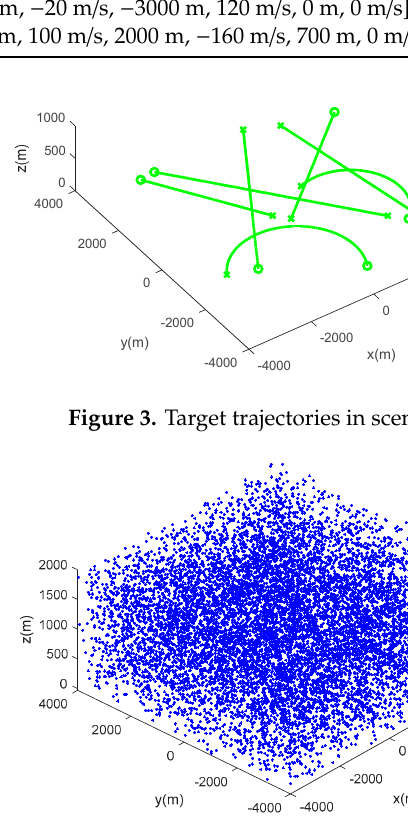
Figure 4. The real measurements with clutter in scenario 1.